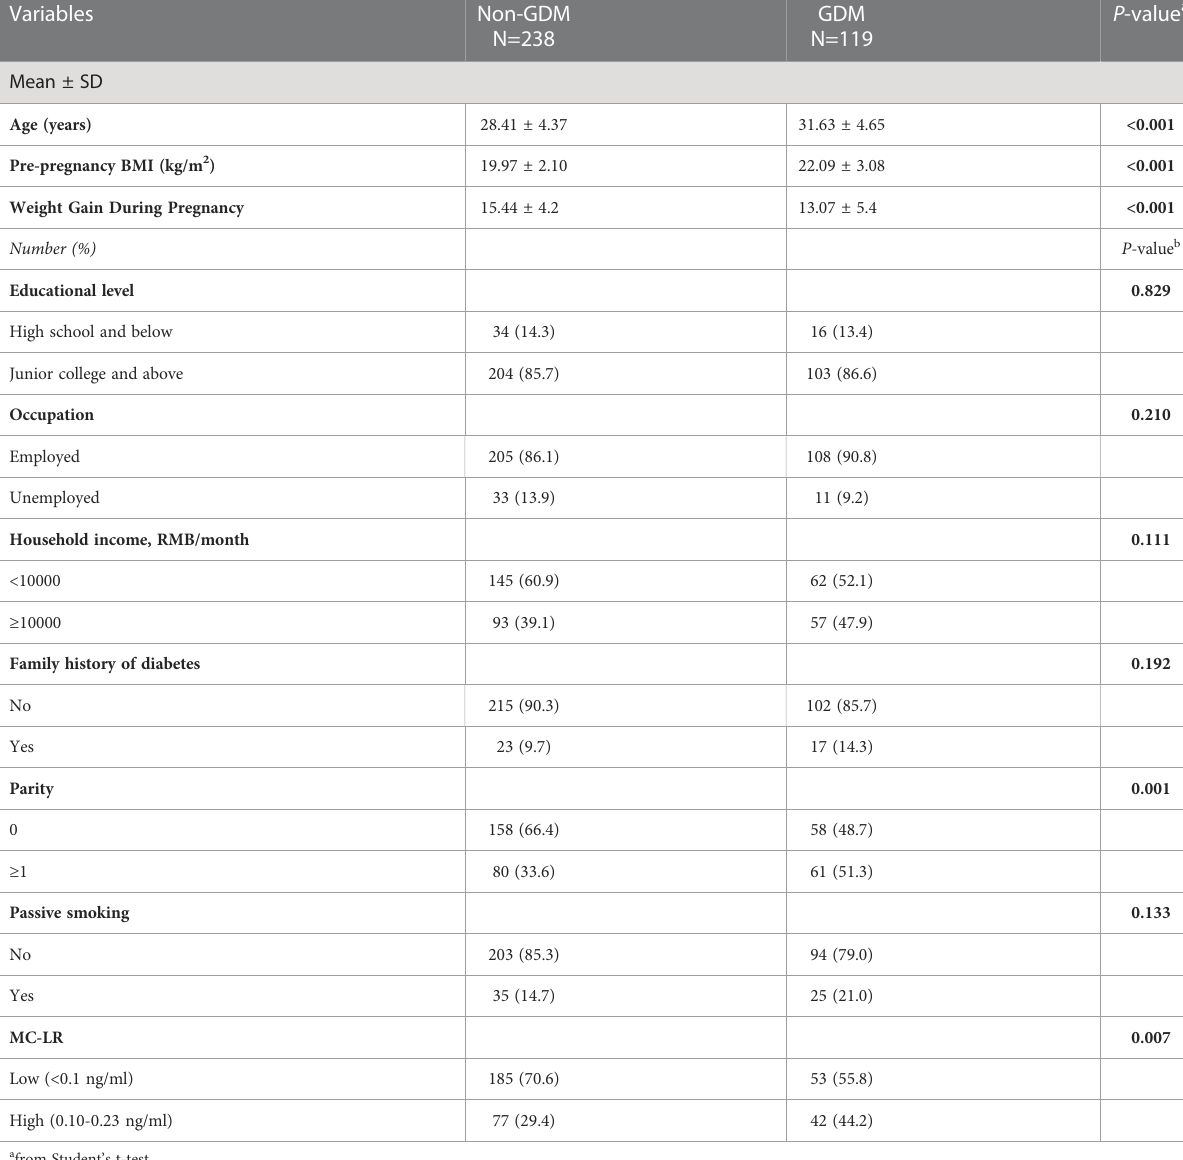
TABLE 1 General characteristic of GDM cases (N=119) and controls